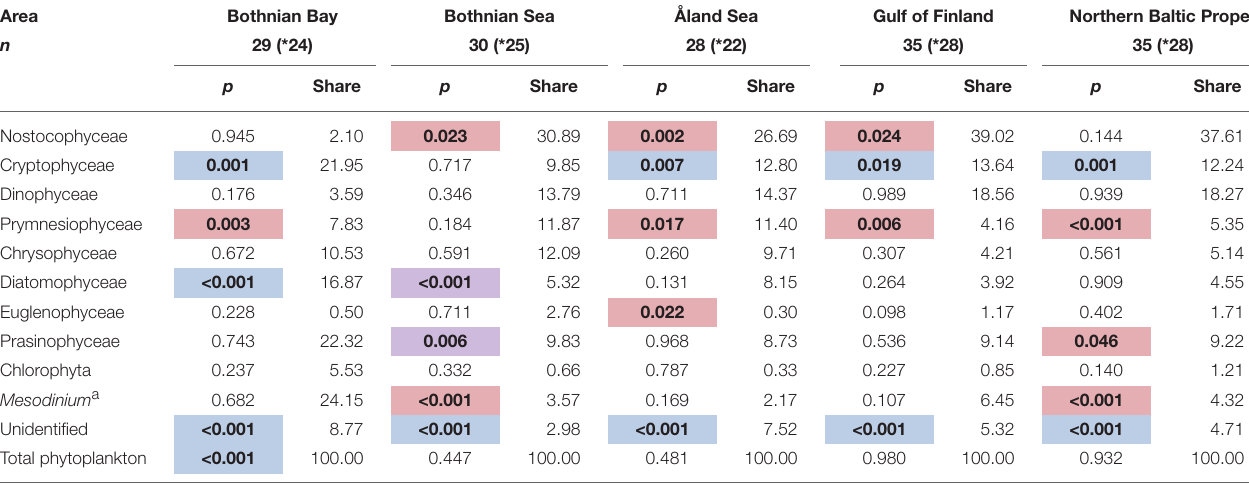
TABLE 2 | Results of the generalized additive models (GAMs) for detection of long-term trends ( p -values; bold = significant trend, p < 0.05; direction: blue, decreasing; red, increasing; purple, non-linear).